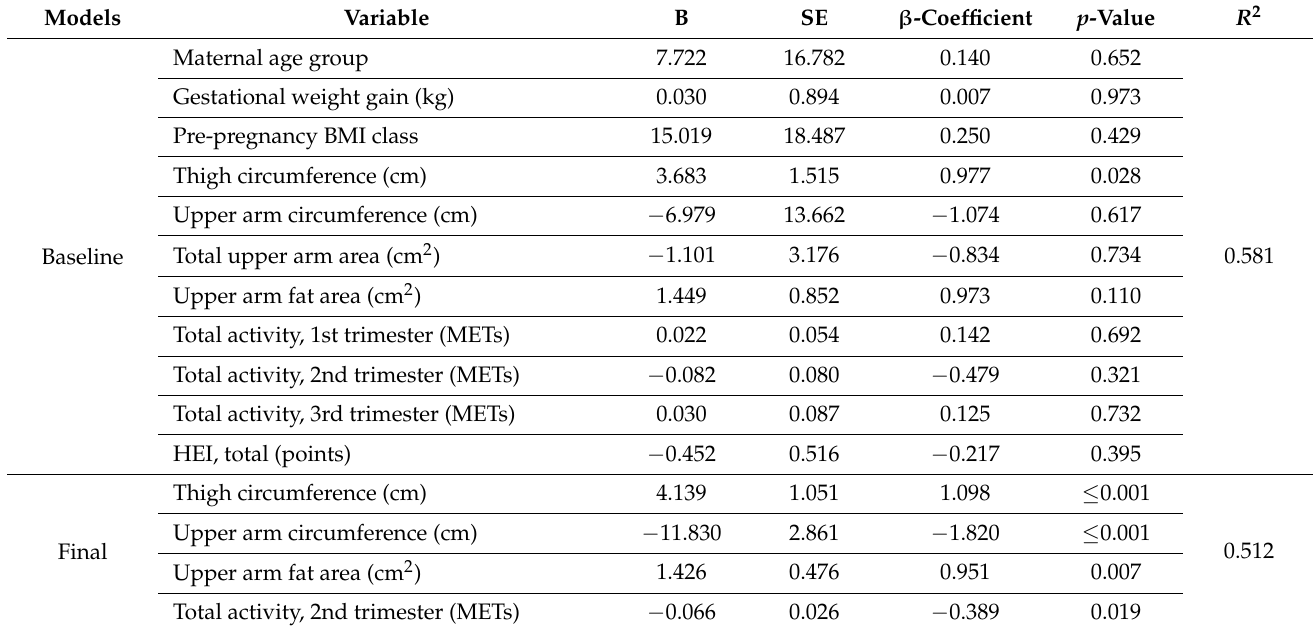
Table 8. Multiple linear regression: IL-6 as an outcome variable (baseline and final model, n =